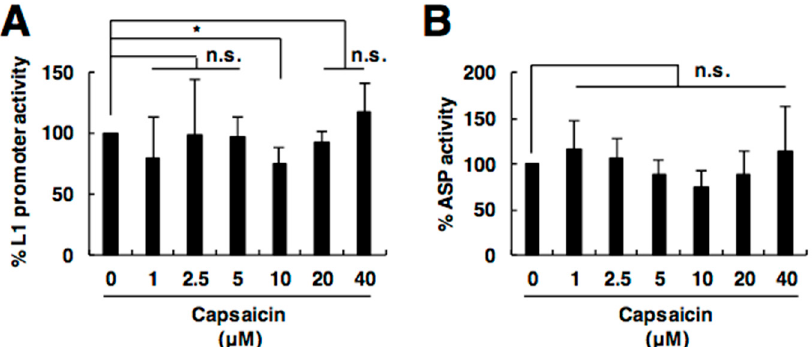
Figure 4. Capsaicin does not affect L1 promoter or antisense promoter (ASP) activity. ( A ) Effect of capsaicin on L1 5 ′ UTR promoter activity. ( B ) Effect of capsaicin on L1 ASP activity. 293T cells were transfected with pGLuc-5 ′ -UTR ( A ) or pGLuc-ASP ( B ), together with pCMV-CLuc. Capsaicin was added at the indicated concentrations at 24 h post-transfection. Luciferase activity in the cells was evaluated at 4 days post-transfection. Values are expressed as the means + S.E. of at least three independent experiments. * p < 0.05; n.s., no significance.